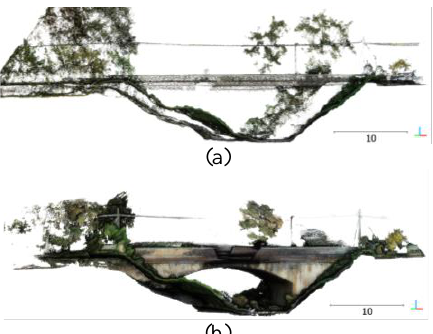
Figure 7. The LiDAR point clouds: (a) AL point cloud, (b) ML point cloud